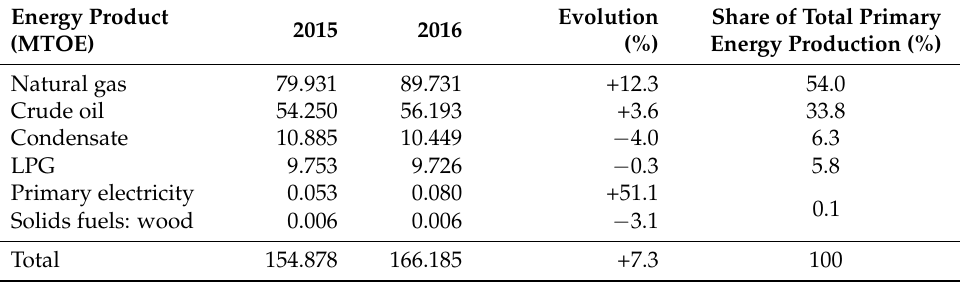
Table 2. Primary energy production in Algeria [54].